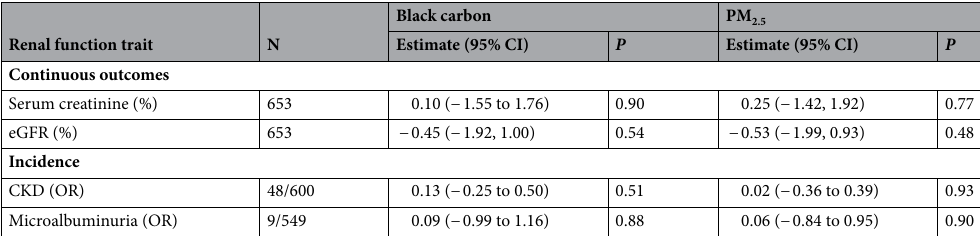
Table 5. Multivariable-adjusted associations between changes from baseline to follow-up in renal function and in the exposure to airborne particulate. eGFR is the glomerular filtration rate estimated from serum creatinine by the CKD-EPI formula. For continuously distributed variables (serum creatinine and eGFR), changes were computed as the follow-up minus baseline values and expressed as a percentage of the baseline value. Incidence refers to new-onset chronic kidney disease (< 60 mL/min/1.73 m 2 ). N indicates the number of participants in the analysis or the number of new-onset cases/number of participants at risk. Associations accounted for clustering of data among participants living at the same address and were adjusted for sex, baseline age (linear and square term), socioeconomic class, follow-up duration, baseline body mass index, and the baseline value of and change during follow-up in mean arterial pressure, heart rate, plasma glucose, the total-to-HDL serum cholesterol ratio, γ-glutamyltransferase, smoking status, and the intake of antihypertensive drugs (all drugs combined). Association sizes were expressed for an interquartile range increment in the airborne